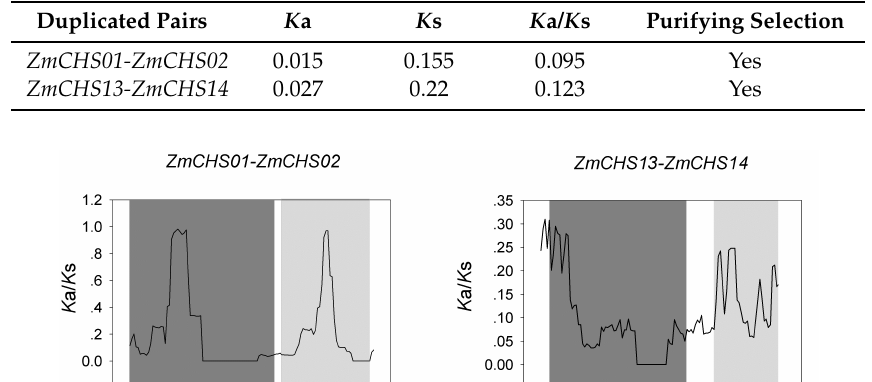
Table 3. K a/ K s analysis for the duplicated ZmCHS paralogs.